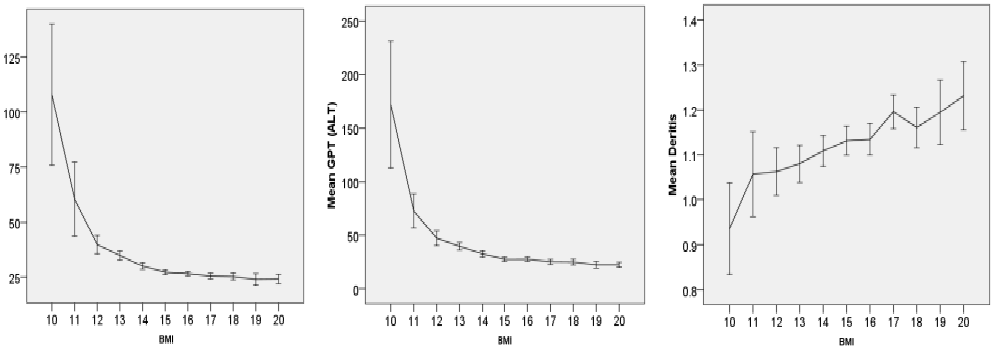
Figure 1. N = 3755—Mean values for GOT (AST), GPT (ALT) and the de Ritis quotient (GOT/GPT) as a function of BMI (integer)—The relationship in the analysis of variance of GOT (F = 55.7), GPT (63.8) and de Ritis (F0 5.7) quotients is highly significant p < 0.001 in each case. Error bars represent 95% confidence interval.